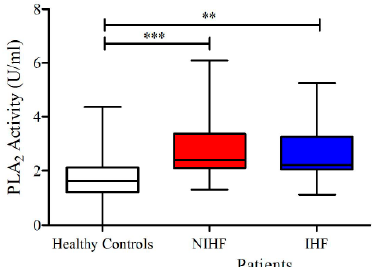
Figure 6. Plasma concentrations of sPLA 2 activity in IHF and NIHF patients and in healthy controls. Data are shown as the median (horizontal block line), the 25th and 75th percentiles (boxes), and the 5th and 95th percentiles (whiskers) (statistical analysis was performed by one-way ANOVA and Bonferroni’s multiple comparison test). ** p < 0.01; *** p < 0.001. As shown in Figure 7, there was an inverse correlation between plasma concentrations of ANGPT2 and ANGPT1 (Figure 7A) and sPLA 2 activity and ANGPT1 (Figure 7B) in NIHF patients. Furthermore, a positive correlation between PLA 2 activity and ANGPT2 was detected in NIHF